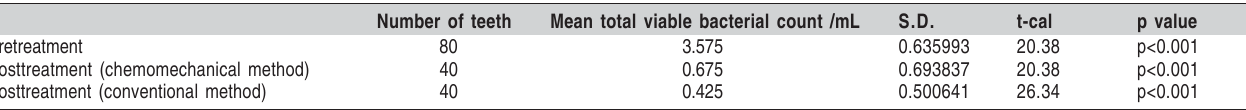
Table 3 - Total viable bacterial count after use of the chemomechanical and conventional methods of caries removal